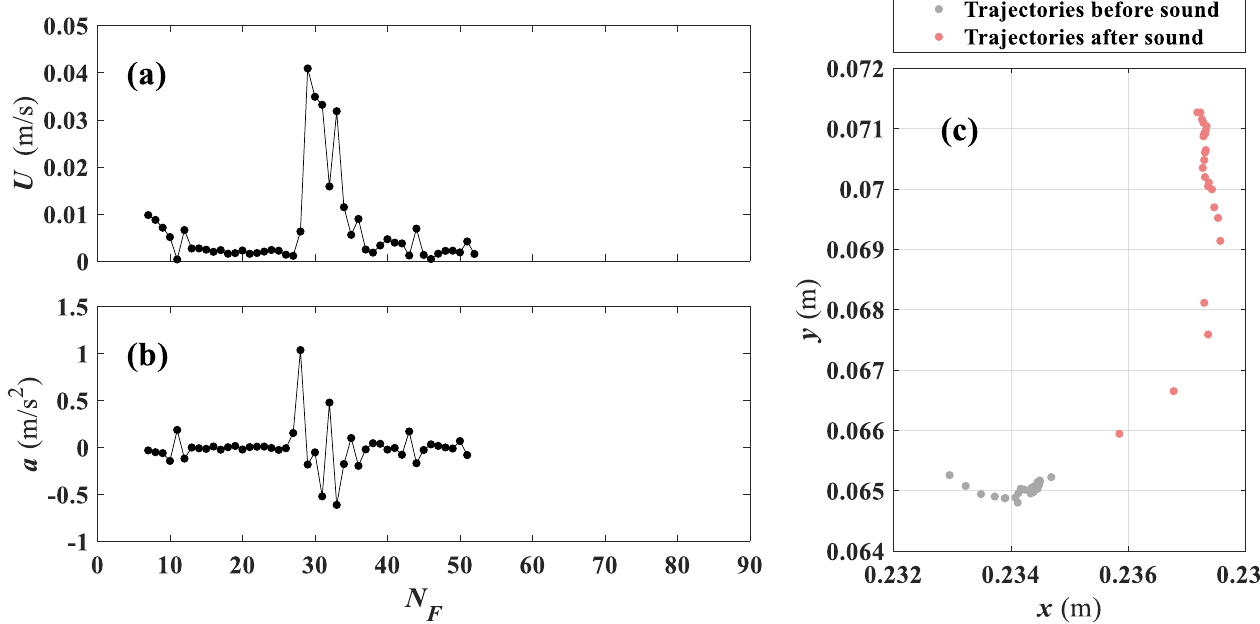
Figure 6. Time series of ( a ) velocity and ( b ) acceleration to illustrate characteristics of larvae identified as actively responding to sound stimuli. ( c ) Trajectory of larvae obtained from the particle tracking algorithm. Data were obtained from 600 Hz tone.